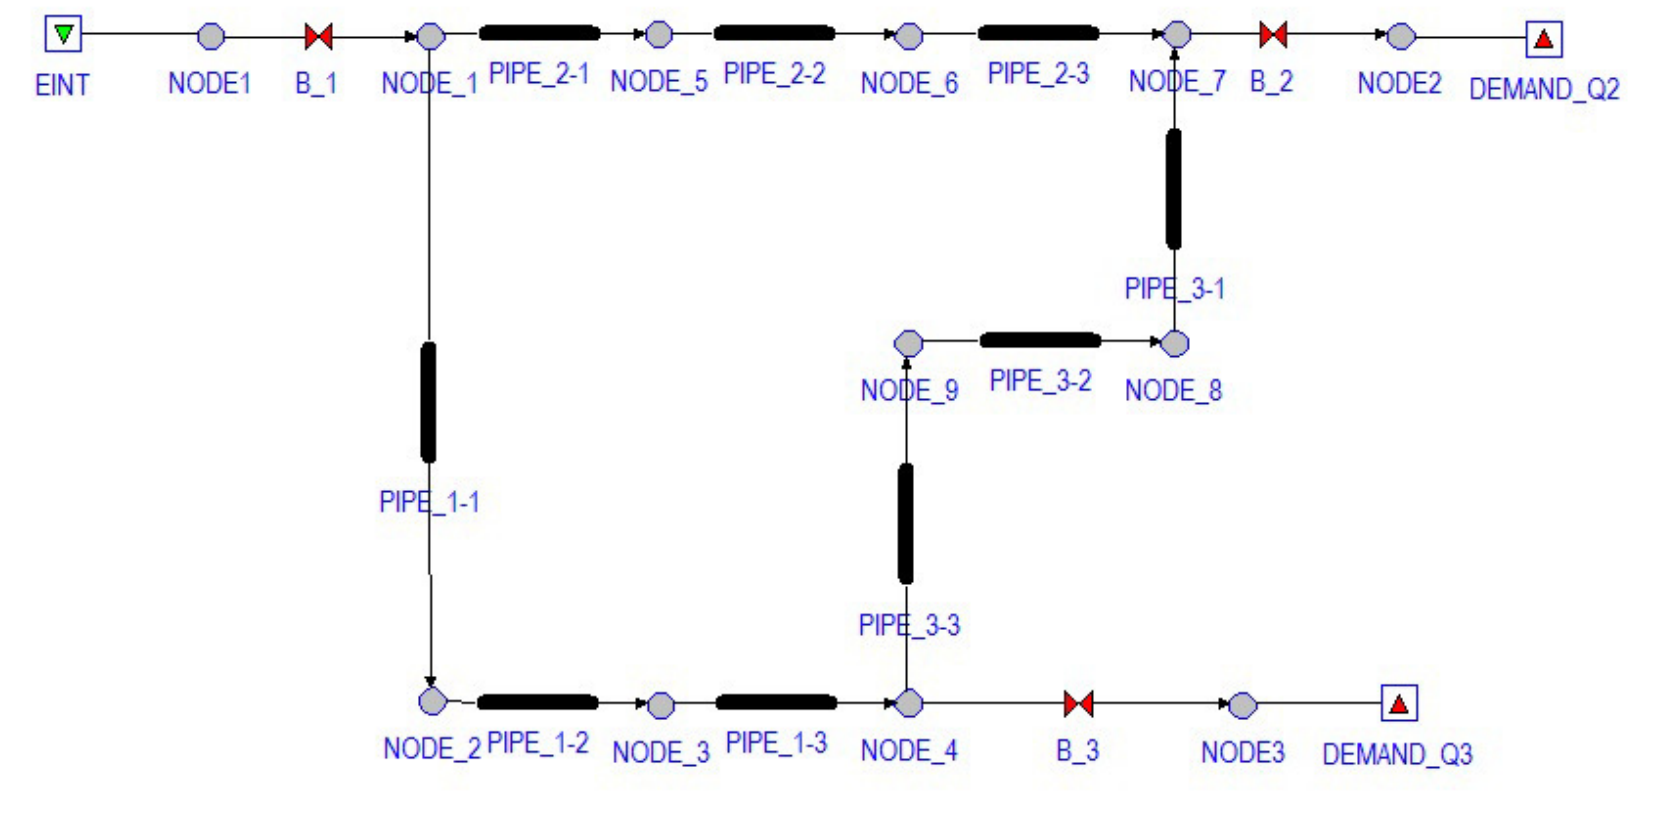
Figure 8. SPS (Stoner Pipeline Simulator) model of the typical